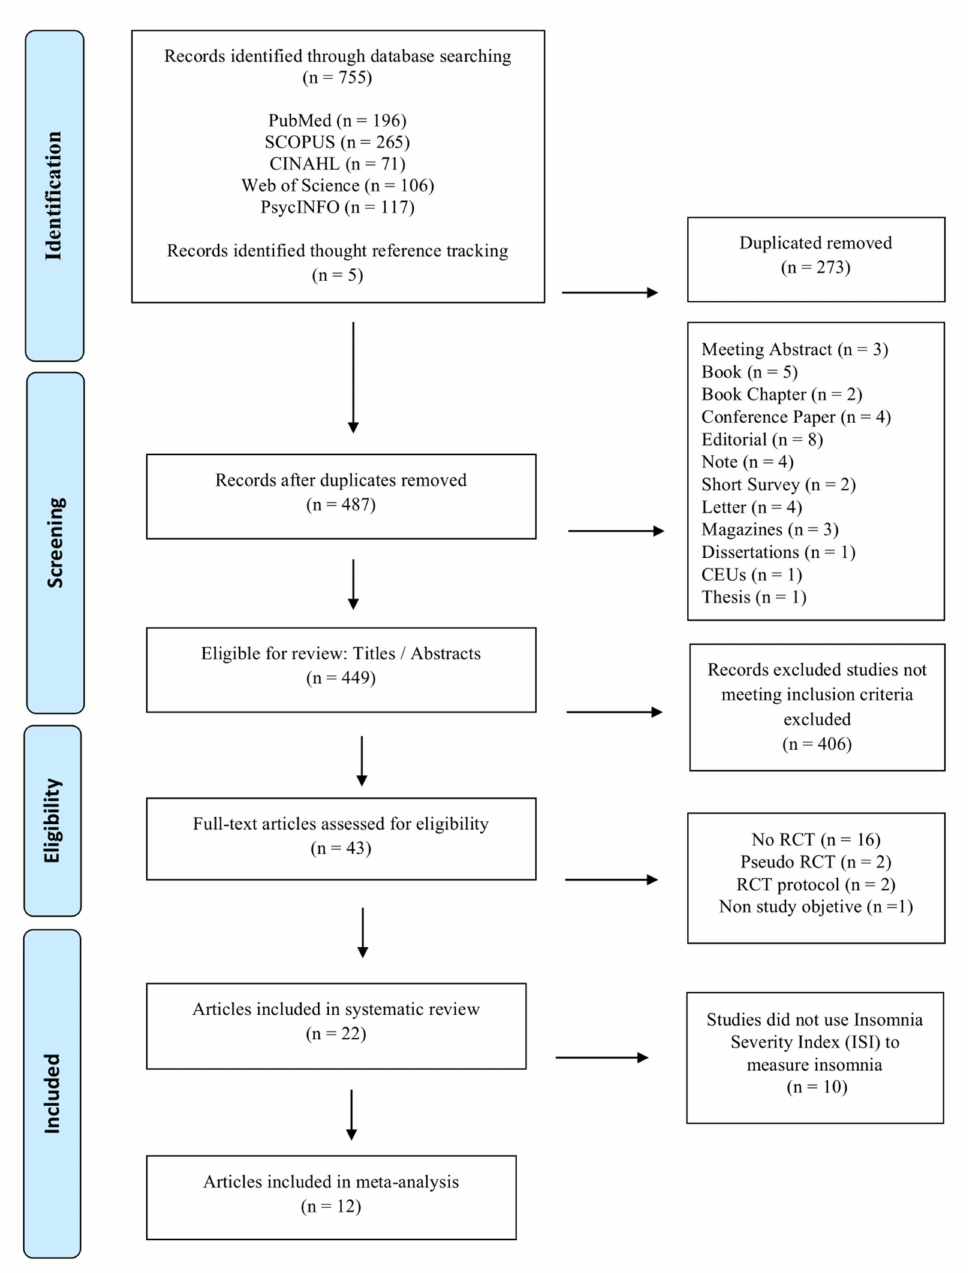
Figure 1. Flowchart of study